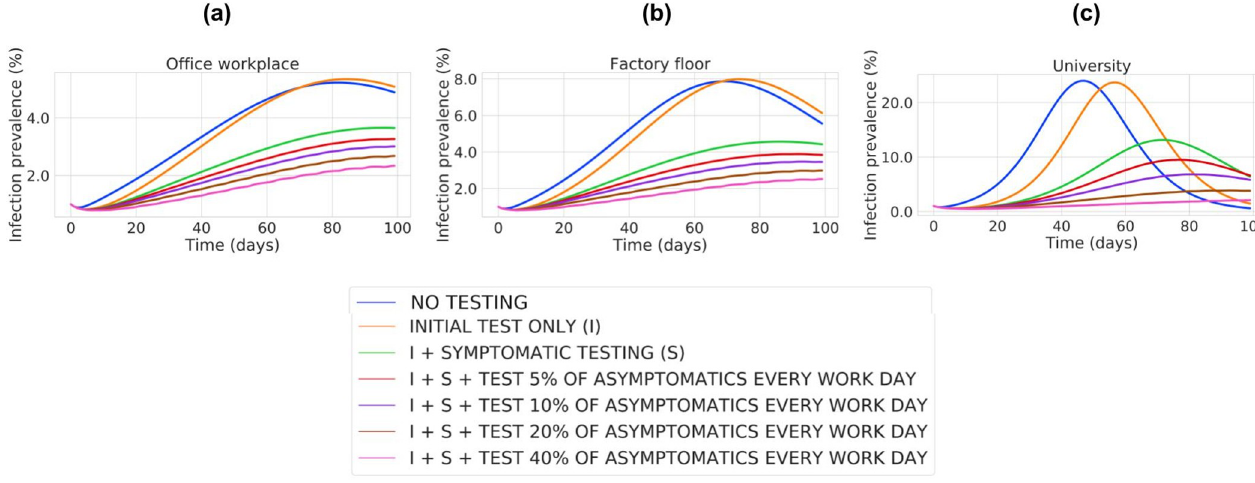
Fig 2. Estimated prevalence trajectory for the three case studies, each under a range of testing strategies. For each case study, the prevalence of employee infection is plotted on the vertical axis (as percentage of the total workplace population), tracked over time (in days) over the course of the simulation on the horizontal axis. For each scenario, the prevalence for the various assessed testing strategies are plotted as distinct curves and colored as per the legend. The parameters used for each case study are described in the main text, with more detail given in S1 File.